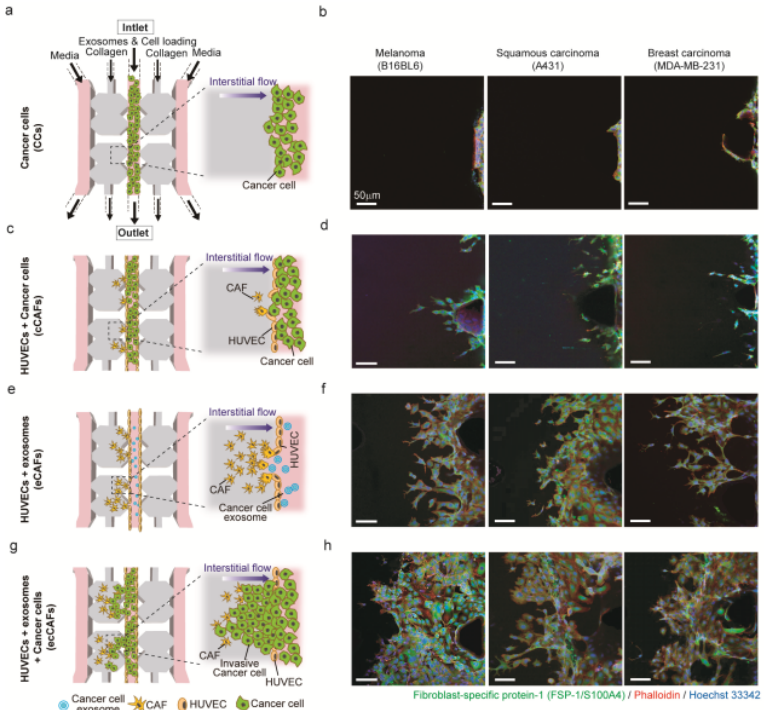
Figure 6. Three-dimensional microfluidic model for cancer cell invasion. ( a , c , e , g ) Schematic diagram showing the progression of cancer invasion; ( b , d , f , h ) confocal images of only cancer cells (CCs) free of human umbilical vein endothelial cells (HUVECs), differentiated cancer-associated fibroblasts (CAFs) induced by cancer cells (cCAFs) or cancer cell-derived exosomes (eCAFs), and cancer invasion created by the exosome-induced CAFs (ecCAFs) from melanoma (B16BL6), squamous carcinoma (A431) and breast carcinoma (MDA-MB-231) cells. This 3D microfluidic model includes an endothelial monolayer composed of HUVECs, CAFs (yellow) induced by cancer cell-derived exosomes (blue) and 3D collagen matrix (gray). Then cancer cells (green) were injected to develop a cancer invasion model. Scale bar: 50 μ m.